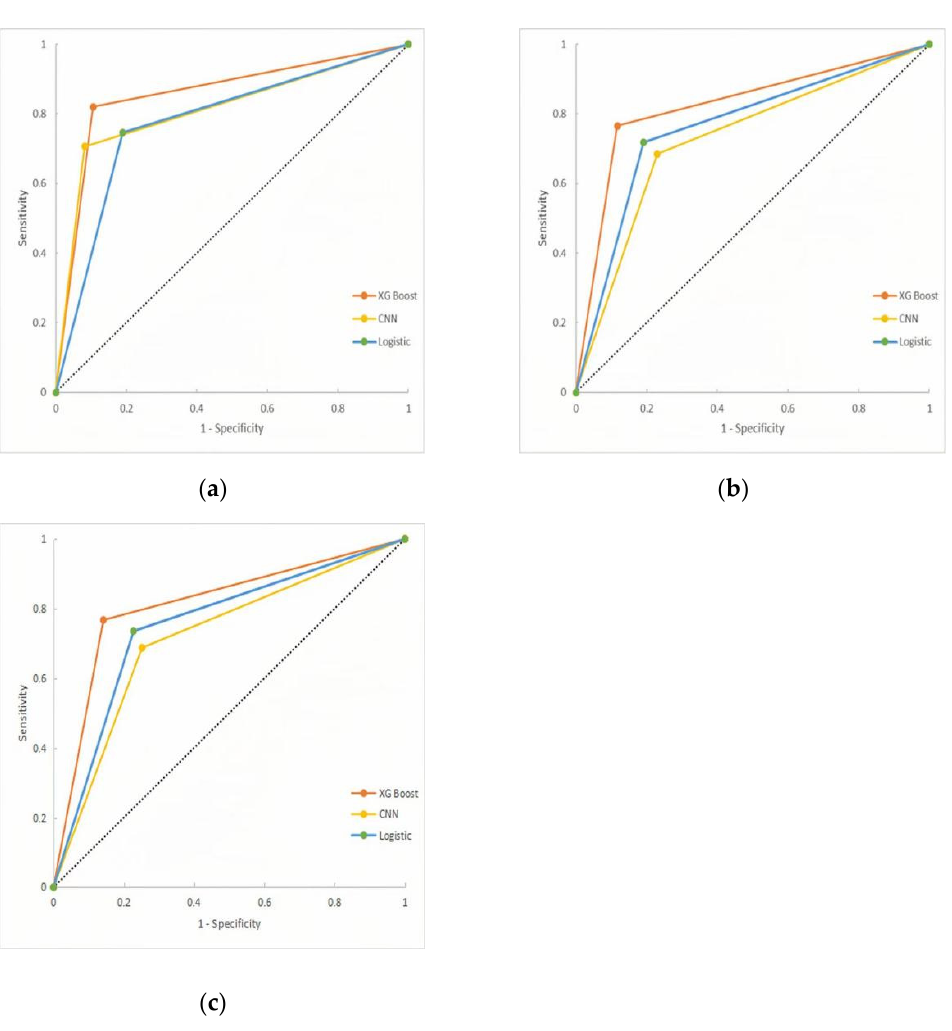
Figure 1. ROC curves of three models ( a ) Training set; ( b ) Test set; ( c ) Validation set. The XG Boost model Brier Score, Log Loss, and Calibration-in-the-large metrics all outperformed the CNN and Logistic regression models. The calibration curves for the training, test and validation sets were all close to the diagonal, with no serious deviations viant. As show in Figure 2a–c.